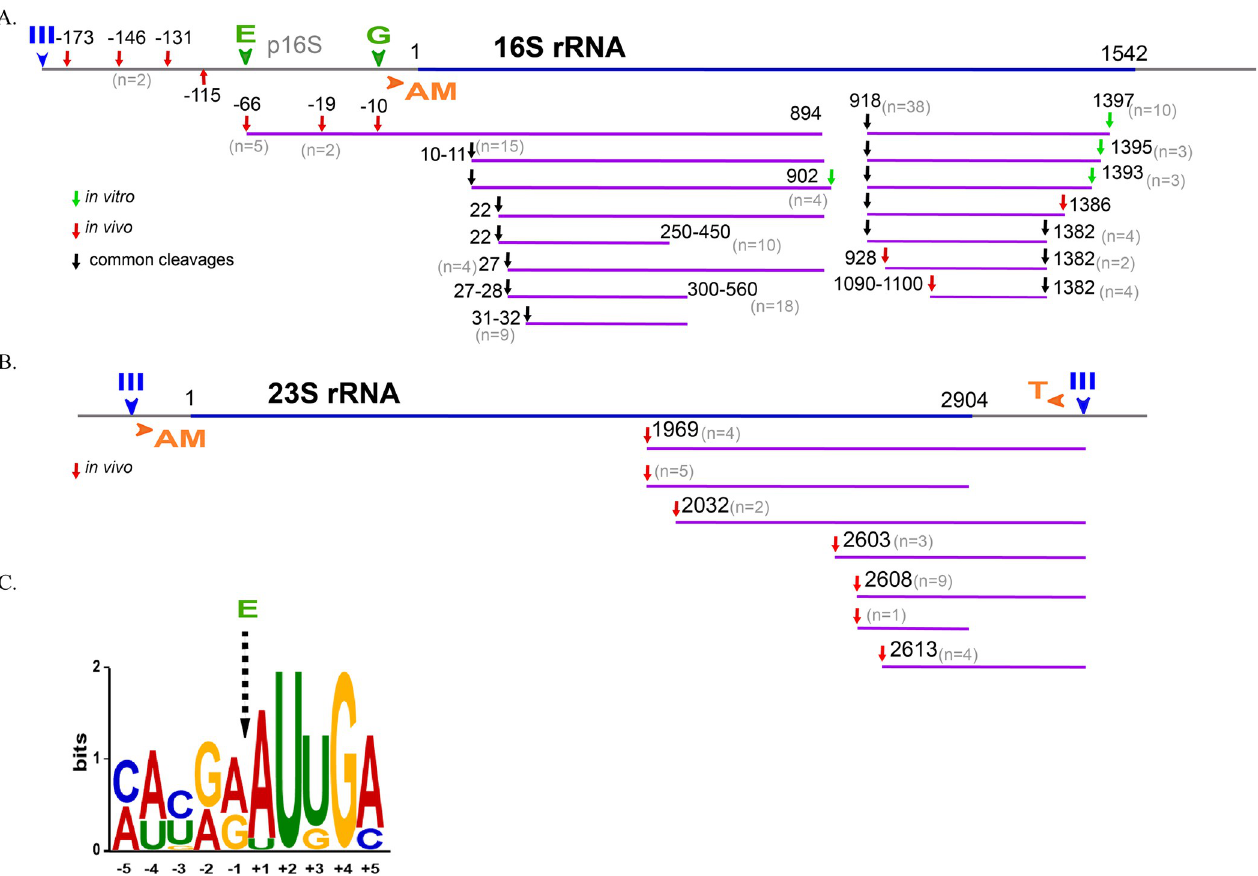
Fig 5. Mapping of RNase E cleavage sites. RNA fragments from the gels in Fig 4 were extracted, purified, and circularized, and the region containing the 3 0 -5 0 junction was PCR amplified (cRACE), as indicated in S6 Fig. After cloning the PCR fragments into a plasmid vector, the 3 0 -5 0 junction was sequenced and the ends aligned with the sequence of 16S or 23S rRNA. In the diagrams representing 16S and 23S rRNA, III (blue), E (green), G (green), AM (orange), and T (orange) represent, respectively, rRNA processing sites for RNase III, RNase E, and RNase G, which are endoribonucleases and RNase AM and RNase T, which are exoribonucleases that trim intermediates to the final mature species. (A and B) Identification of cleavage sites in 16S rRNA and 23S rRNA. The color-coded key indicates cleavages that were mapped in vivo, in vitro, or both in vivo and in vitro. The number of times a site was sequenced is indicated (n). The data underlying the schemes shown in Fig 5A and 5B can be found in S1 Table. (C) Consensus sequence of rRNA cleavage sites that were mapped in